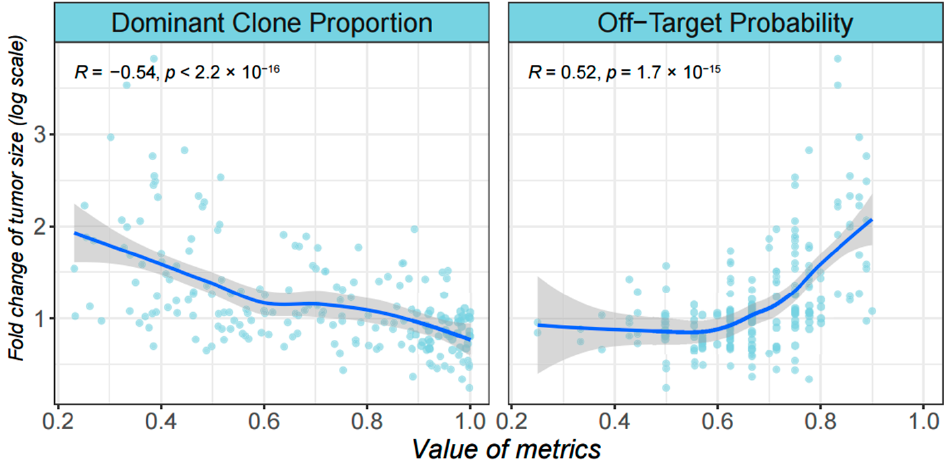
Figure 5. Correlations between the treatment outcome and the ITH metrics. Each replicated simulation is represented by dots on the scatterplot, where the x axis denotes the values of the two metrics when the therapy begins, and the y axis denotes log-transformed fold change of tumor size at 50 iterations after the therapy is over.